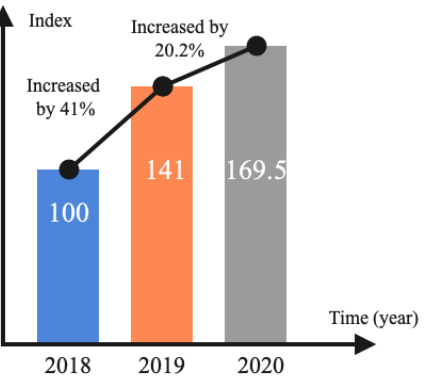
Figure 6. Change trend of platform industry APP development index in 2018–2020.